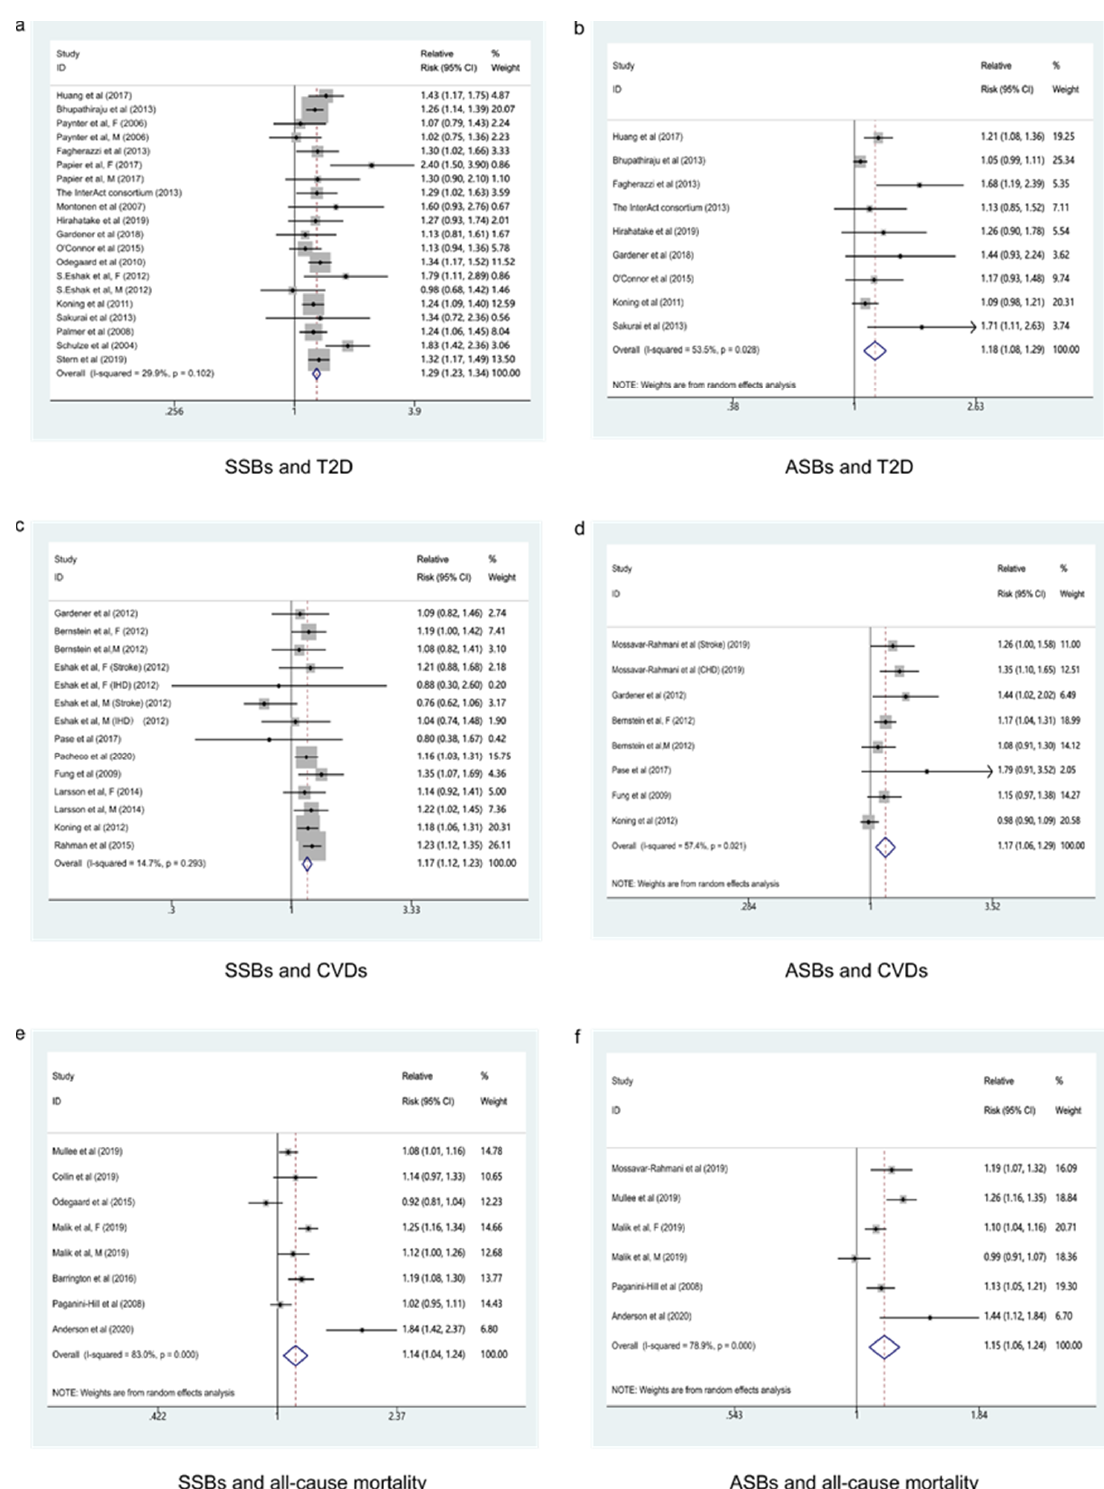
Figure 2. Forest plot of RR for the association of sugar-sweetened beverages and artificially sweetened beverages consumption with the risk of type 2 diabetes, cardiovascular diseases, and all-cause mortality. ( a ) Forest plot of RR for SSBs and T2D. ( b ) Forest plot of RR for ASBs and T2D. ( c ) Forest plot of RR for SSBs and CVDs. ( d ) Forest plot of RR for ASBs and CVDs. ( e ) Forest plot of RRfor SSBs and all-cause mortality. ( f ) Forest plot of RR for ASBs and all-cause mortality. SSBs, sugar-sweetened beverages; ASBs, artificially sweetened beverage; T2D, type 2 diabetes; CVDs, cardiovascular diseases.